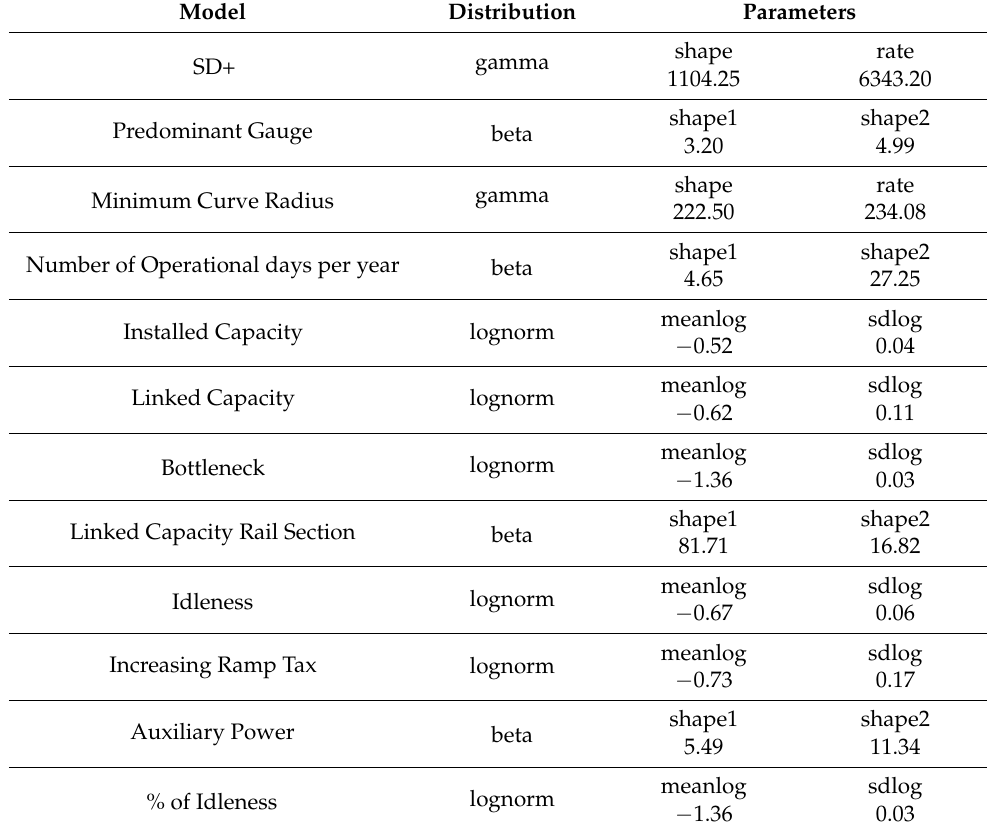
Figure 12. Cause and effect framework for selected attributes at 0.975 percentile (weights are derived from step 2, signs are derived from Olden and Jackson’s (2002) [48] sensitivity analyses). Table 4. Distributional fit for residuals obtained in models